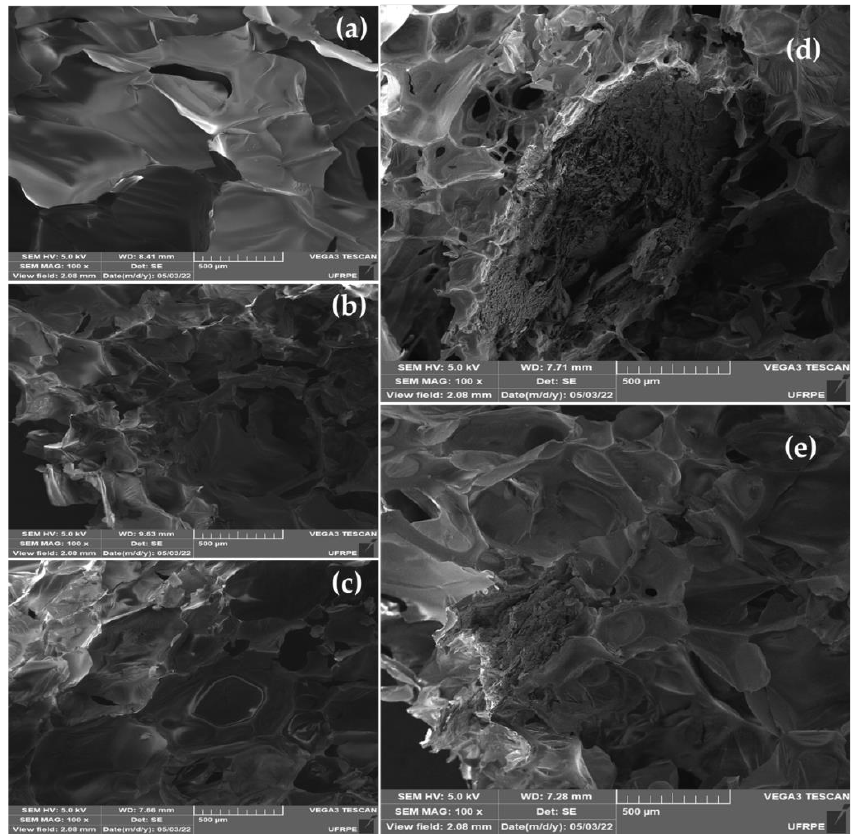
Figure 4. SEM micrographs of the composites: PU/VMT 0% ( a ), PU/VMT 5%( b ), PU/VMT 10% ( c ), PU/VMT 15% ( d ), and PU/VMT 20% ( e ).